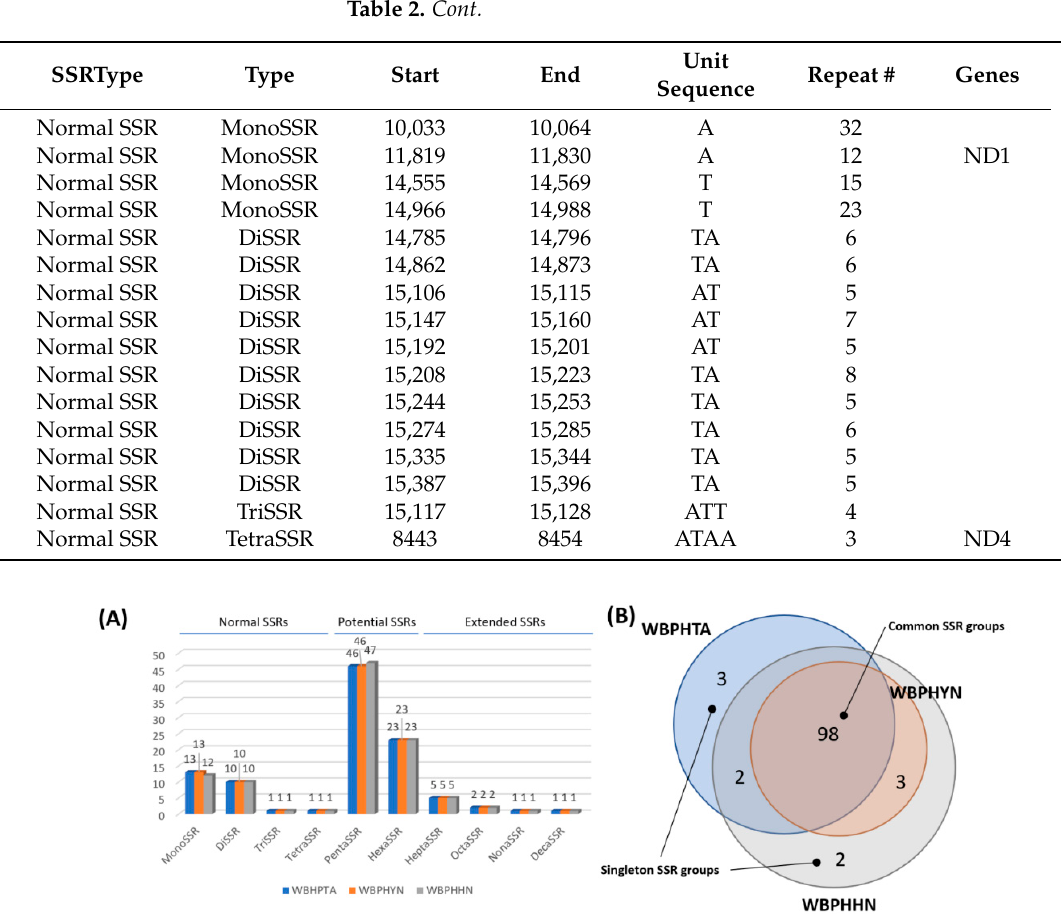
Table 3. List of simple sequence repeats (SSRs) from SSR groups containing one or two mitogenomes. No SSR Group